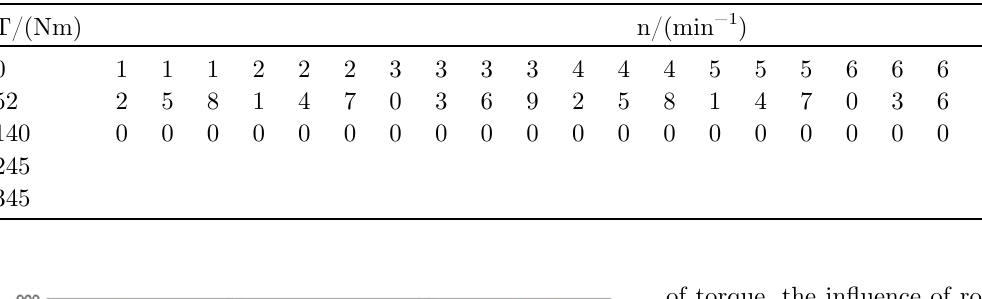
Table 3. Experimental condition.